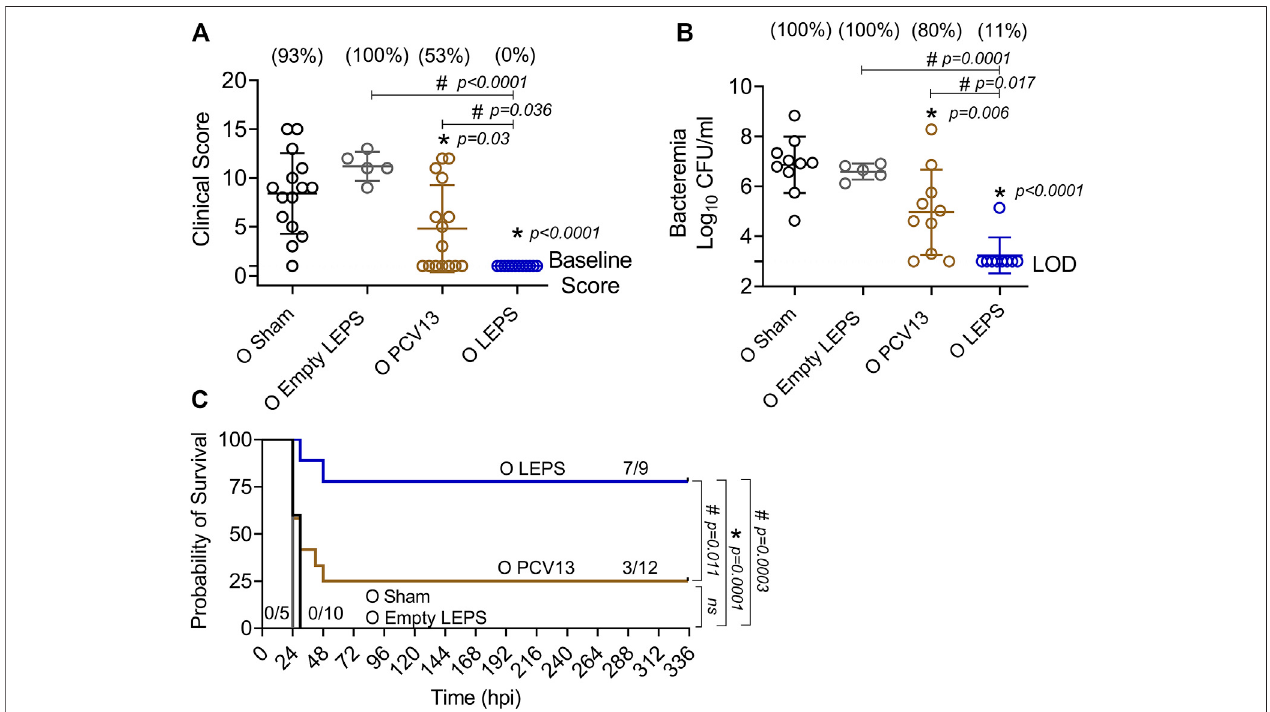
FIGURE 7 | LEPS vaccination protects old mice against invasive pneumococcal infection. Old (18 – 22 months) C57BL/6 mice were immunized with LEPS containing serotype 4 capsular polysaccharide antigen, PCV13, or the controls (Sham or Empty LEPS vector). Four weeks later (timeline presented in Figure 1B ), mice wereinfectedintra-tracheallywith5 × 10 5 CFUof S.pneumoniae serotype4TIGR4strain.Clinicalscores (A) andbacterialnumbersinthebloodalongwiththeincidence (% noted above each group) ofbacteremia (B) were determined 24 hpost-infection.Survivalwasalsofollowedover time (C) . (A,B) Asterisks(*) indicate signi fi cant differences with respect tothe Sham group, and hash signs (#) indicate signi fi cant differences between the indicated groups as calculated by one-way ANOVA followed byTukey ’ stest. Pooled dataarepresentedasmean ± SD and each dotrepresentsonemouse. (C) Asterisks(*)indicate signi fi cantdifferences with respecttothe Sham group (ns: not signi fi cant), and hash signs (#) indicate signi fi cant differences between the indicated groups as determined by the log-rank (Mantel-Cox) test. Fractions denote surviving mice. Pooled data from two separate experiments with n (cid:2) 10 mice in the Sham group, n (cid:2) 5 mice in the Empty LEPS group, n (cid:2) 12 mice in the PCV13 group, and n (cid:2) 9 mice in the LEPS group are shown. LOD: limit of